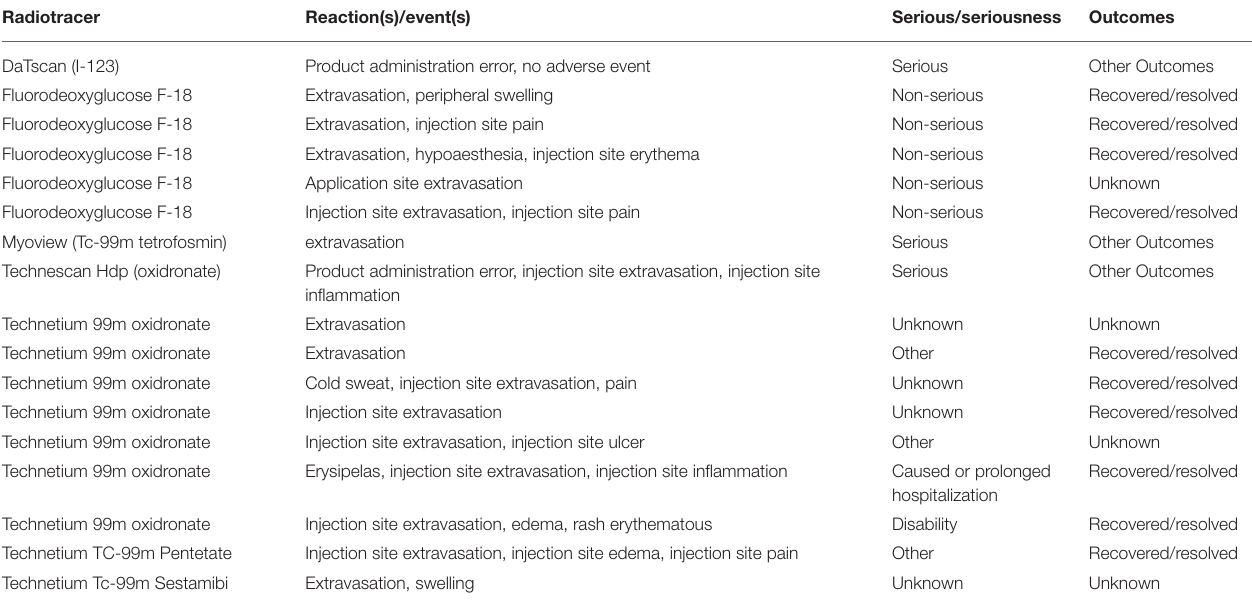
TABLE 2 | EV search line listing report.